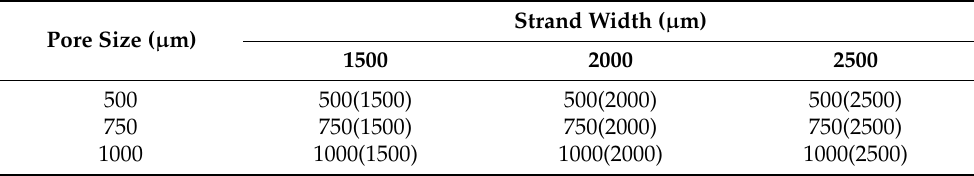
Table 1. Overview of the used